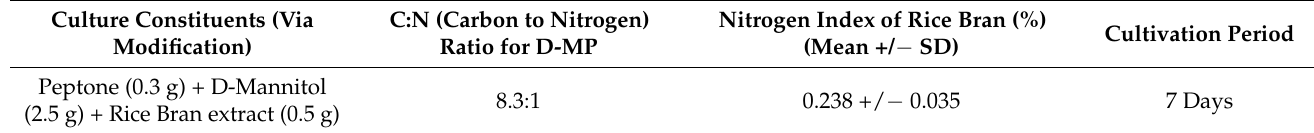
Table 1. Culture medium composition and growth